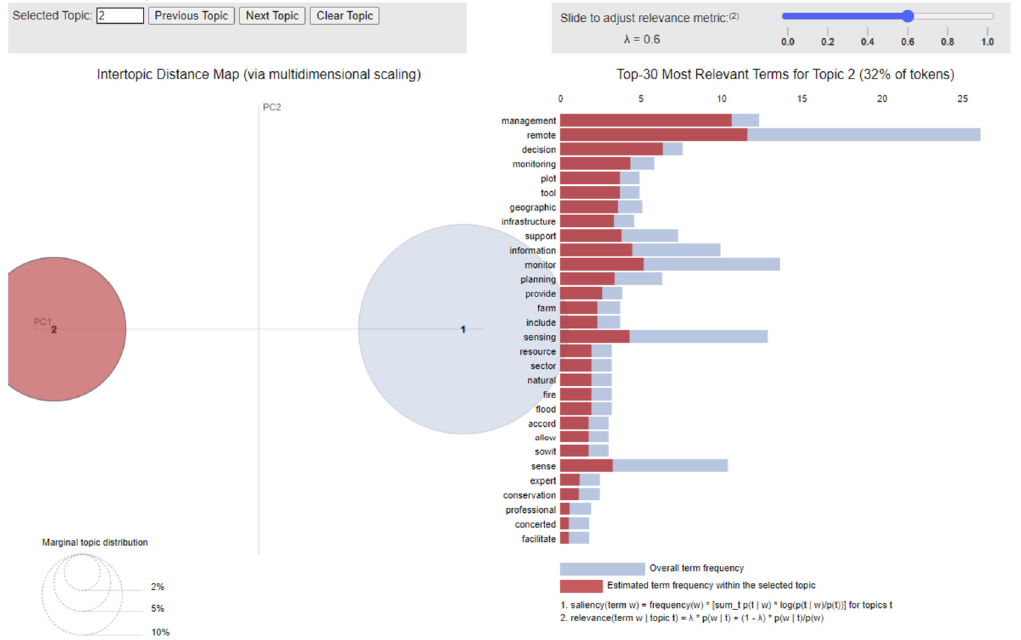
Figure 4. Term relevance in topic two. For the salient terms see Chuang et al. (2012) and for the relevant terms see Sievert & Shirley (2014).